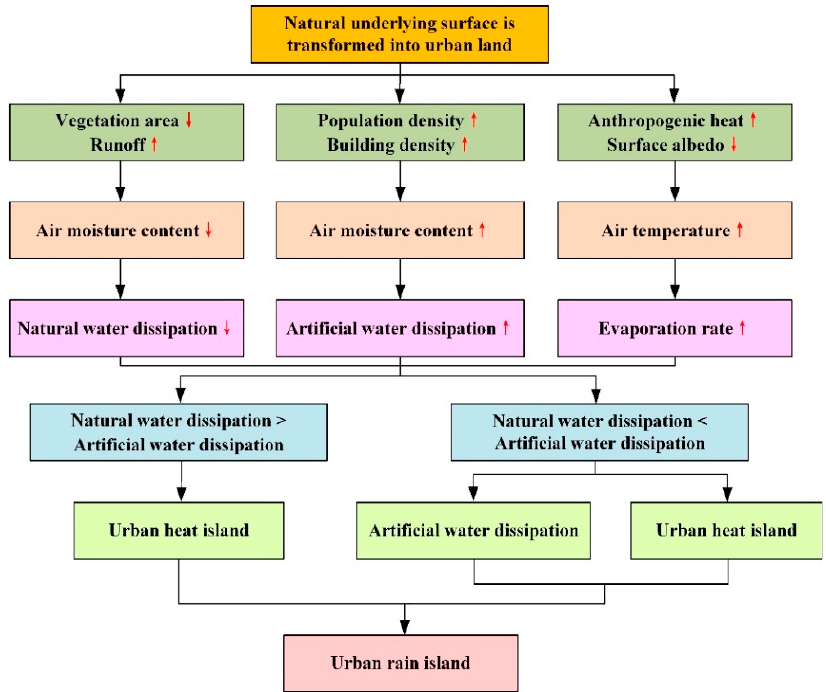
Figure 4. Conceptual model of how urbanization influences the rain island effect. Arrows indicate the direction of movement.